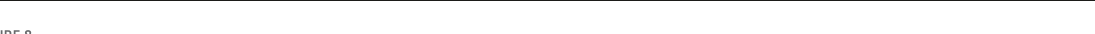
FIGURE8 hypertensive rats. The L-NAME hypertensive model was found to have an enlarged carotid body, that was due to enhanced extracellular matrix deposition. The density of type I cell nuclei was decreased by 31% in the L-NAME group, although the type I cells themselves appeared hypertrophied and the cytoplasm contained vacuoles. (E,F) H&E stains from human carotid bodies. (E) Depicts carotid body lobule from a woman of 71 years. The glomic tissue is arranged into discrete clusters each comprising a central core of rounded type I cells (labeled C for chief cell) surrounded by a thin, discontinuous rim of elongated type II cells (labeled S for sustentacular). (F) Depicts carotid body of a 61-year-old man with coarctation of the aorta. In this congenital disorder carotid bodies are exposed to an elevated systemic blood pressure, and in this case the patient had severe left ventricular hypertension. The carotid body was enlarged, and the area of the largest lobule was considerably greater than the control cases due to the proliferation of type II cells, that were associated with many axons of unknown origin. In this case, type II cells accounted for 73% of the total cells in the carotid body. Type I cells had been compressed and the size of the type I cell clusters was much reduced. Many type I cells were found to have dark staining nuclei with compact chromatin, highly vacuolated cytoplasm clusters had a great degree of type I cell atrophy. Figure reproduced with permission from Heath and Smith